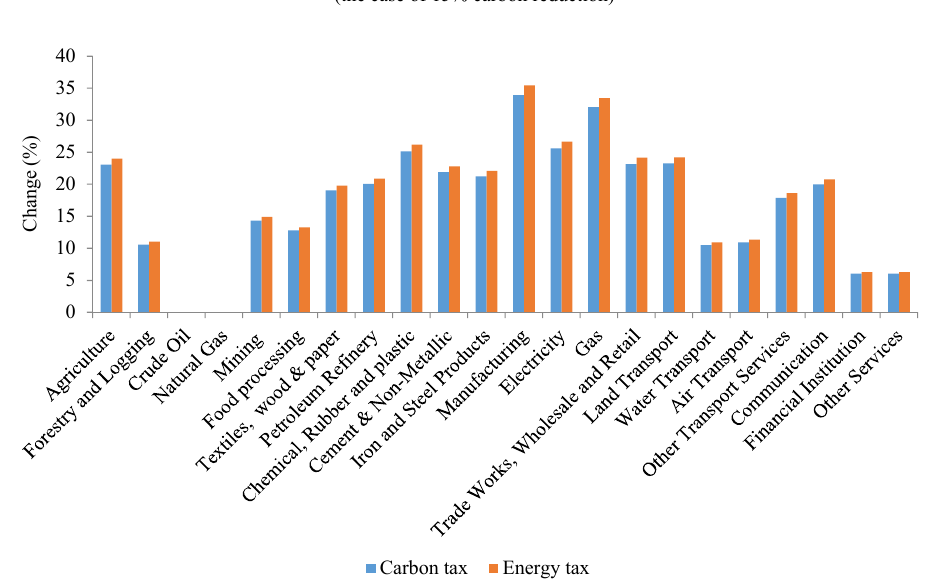
Fig. 8: Changes in aggregate household consumption in the 15% carbon reduction (lump-sum transfer case)